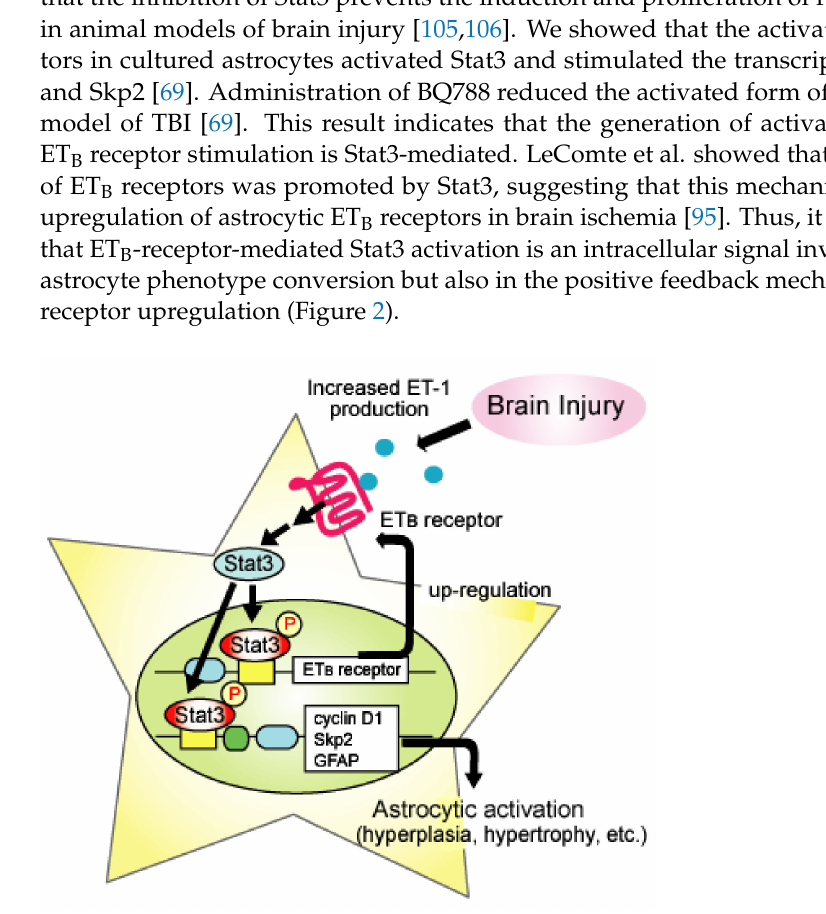
Figure 2. Positive feedback mechanism of the astrocytic ET B receptor signal through activation of Stat3. Activation of astrocytic ET B receptors stimulates the transcription of cyclin D1, S-phase kinase-associated protein 2 (Skp2), and GFAP through Stat3. Increases in cyclin D1, skp2m, and GFAP proteins are involved in proliferation and hypertrophy associated with phenotype conversion to reactive astrocytes. Activated Stat3 also promotes transcription of ET B receptors. The upregulation of ET B receptors results in enhancement in Stat3-mediated gene expression in